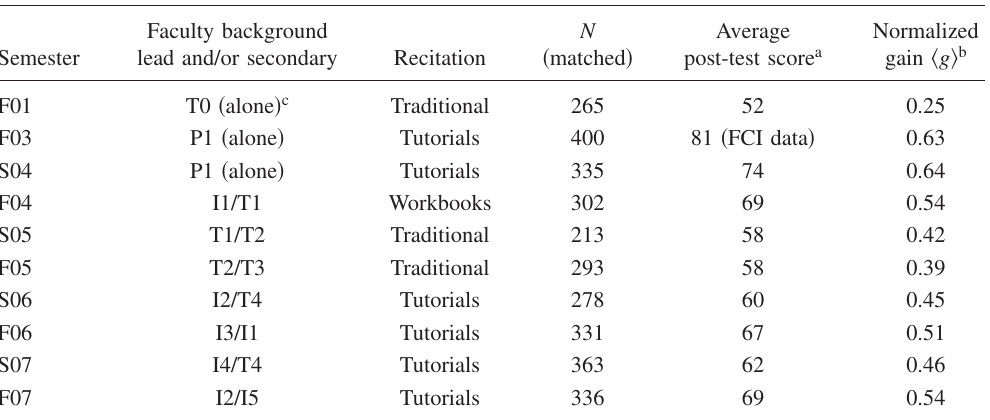
TABLE I. Summary of FMCE normalized gains over eight semesters of data collection.